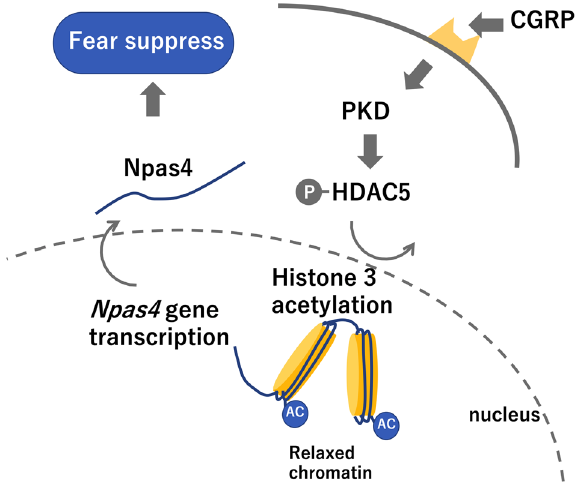
Figure 5. Model CGRP-induced reduction of fear memory retention through epigenetic regulation via the PKD-HDAC5- Npas4